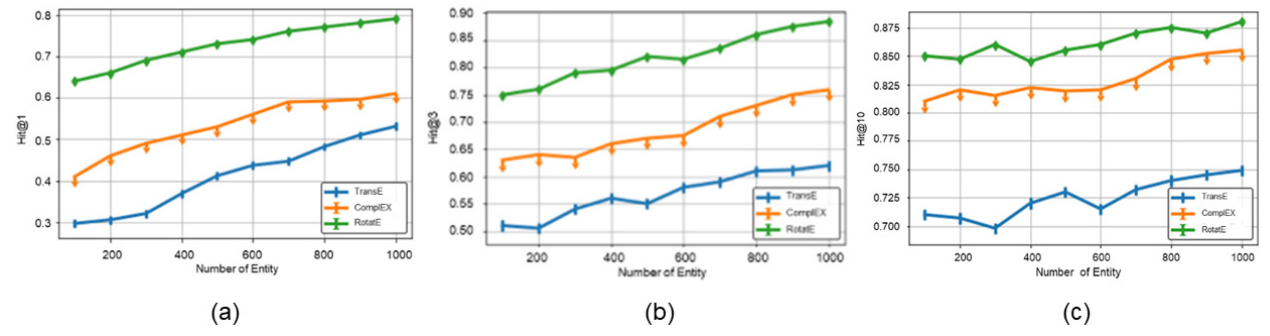
Figure 3. Hit@N of the score function. ( a ) Description of Hit@1 with three knowledge graph embedding models. ( b ) Description of Hit@3 with three knowledge graph embedding models. ( c ) Description of Hit@10 with three knowledge graph embedding models.